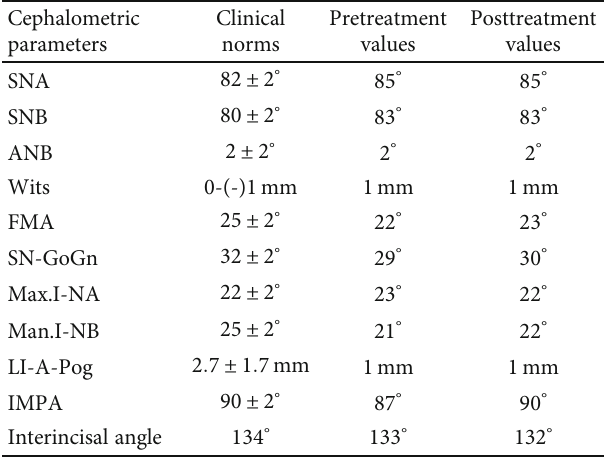
Figure 8: Posttreatment cephalograms. Table 1: Comparative cephalometric